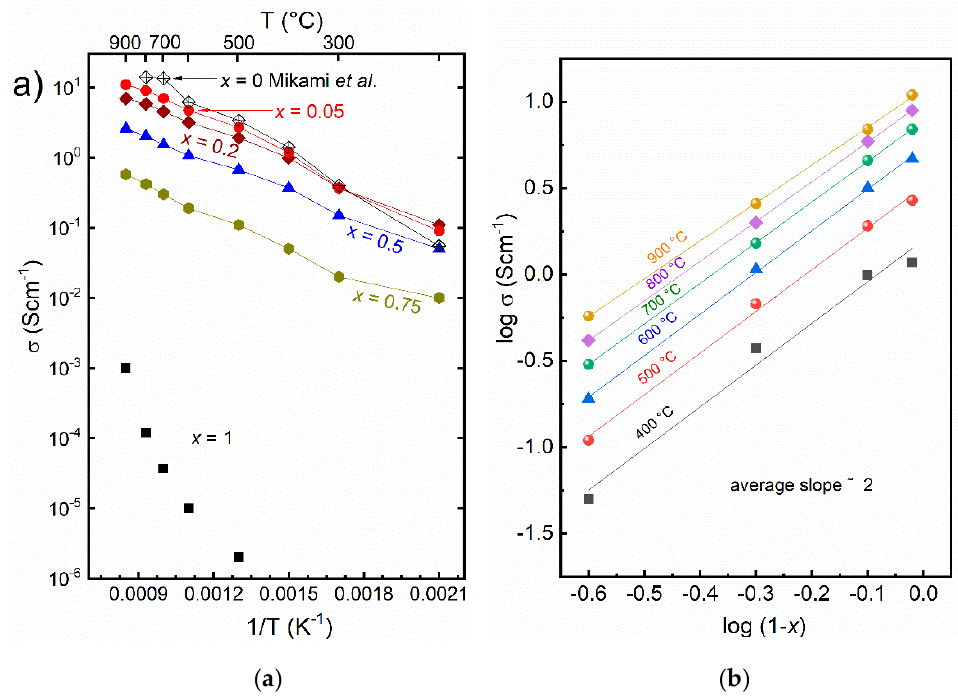
Figure 4. ( a ) Arrhenius plot of electrical conductivity of Ca 3 Co 2- x Mn x O 6 versus 1/T. The data for Ca 3 Co 2 − x Mn x O 6 ( x = 0) are from Mikami et al. [12]. ( b ) Double-logarithmic plot of isothermal conductivities from 400 to 900 °C versus (1 − x ) suggesting a slope of 2 at the higher